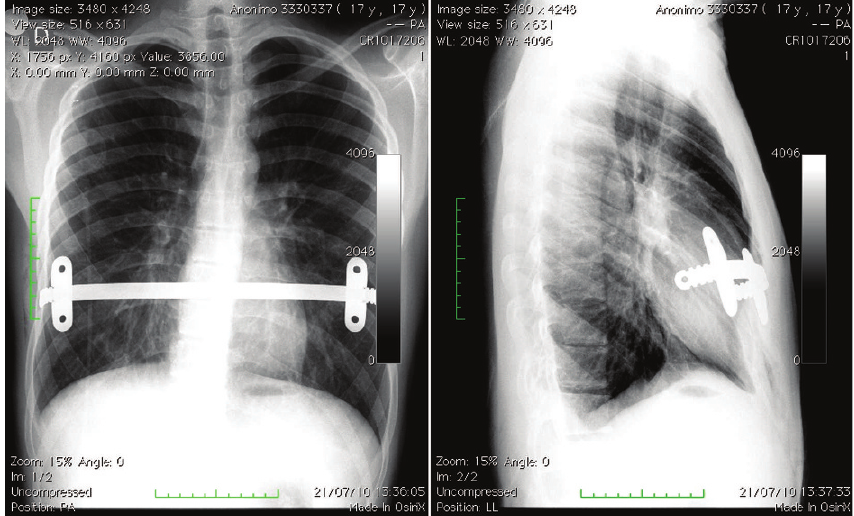
Figure 4 - A and B: Examples of the new